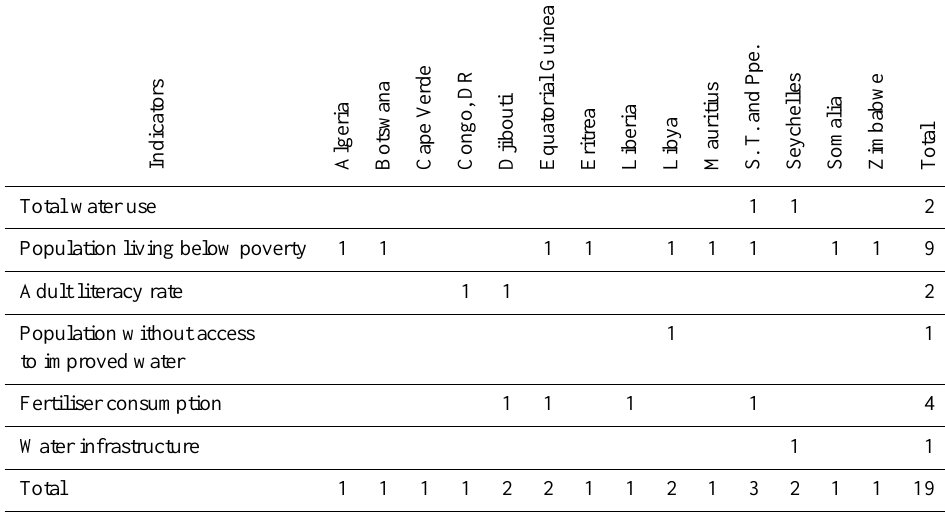
Table 2. Table of missing data per country and indicator. Only countries and indicators with missing data are shown.